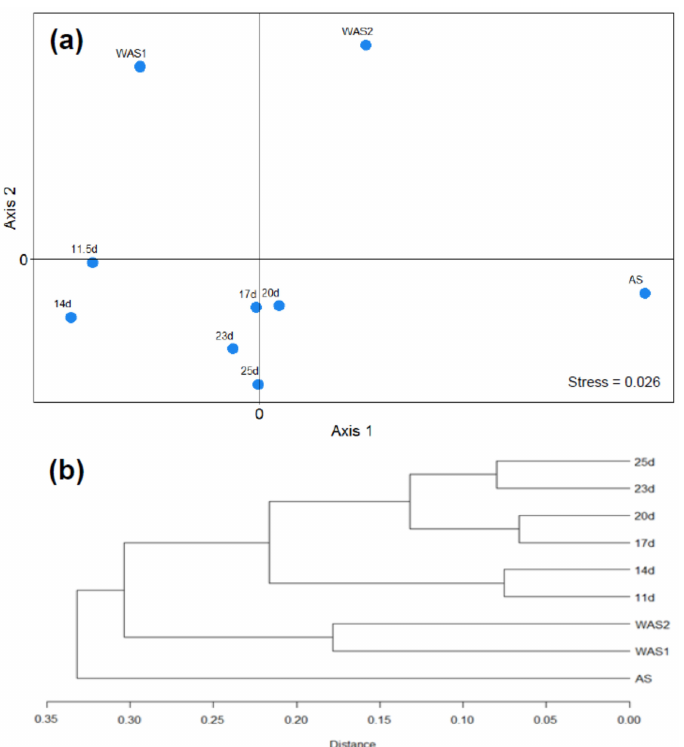
Figure A1. NMDS ordination plot ( a ) and dendrogram ( b ) for the identified taxa in the samples at the genus level.